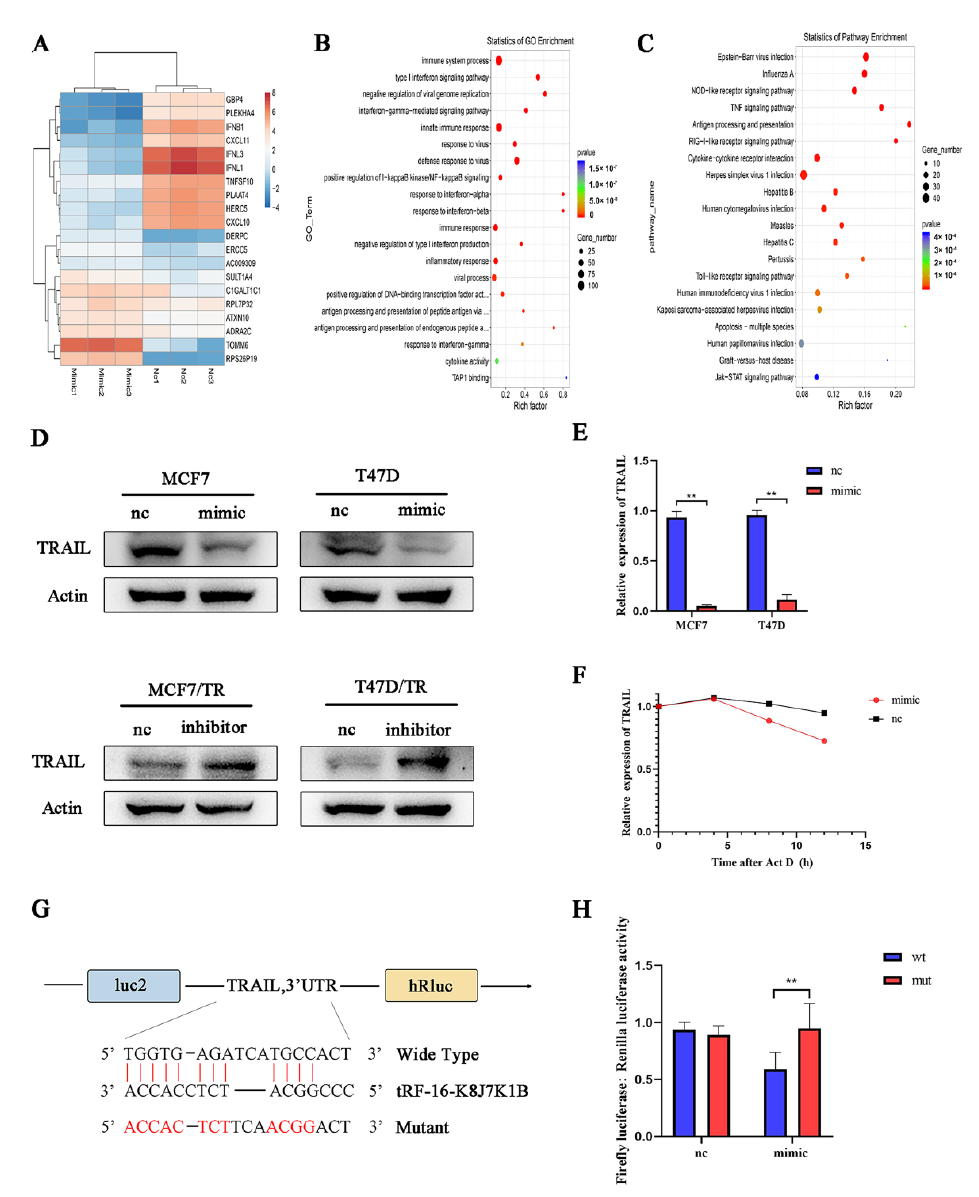
Figure 4. TRAIL is the target gene of tRF-16-K8J7K1B. ( A ) Heat map shows the change in mRNA expression in tRF-16-K8J7K1B-overexpressed MCF7 cells compared with the control group. ( B ) GO analysis and ( C ) KEGG analysis indicate the enriched pathways by the target genes of tRF-16-K8J7K1B. ( D ) Western blotting and ( E ) RT-qPCR revealed the expression of TRAIL in MCF7 and T47D cells transfected with tRF-16-K8J7K1B mimic or control. ( F ) RT-qPCR detected the expression of TRAIL in MCF7 cells after 0, 4, 8, and 12 h of ACTD treatment. ( G ) The predicted tRF-16-K8J7K1B binding site in TRAIL. ( H ) Luciferase reporter assay was performed to detect the luciferase activity of WT or MUT TRAIL 3′ UTR after co-transfection with tRF-16-K8J7K1B mimics or negative control. Data are presented as mean ± SEM. ** p < 0.01. The uncropped blots are shown in Figure S4.